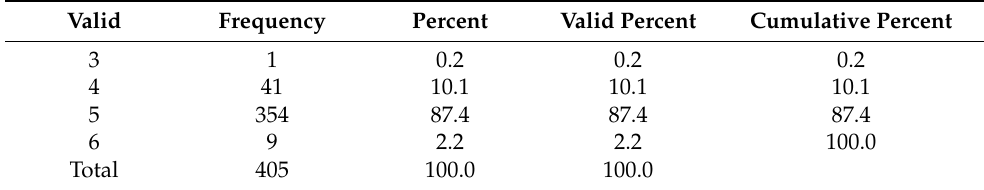
Table A4. Academic Year